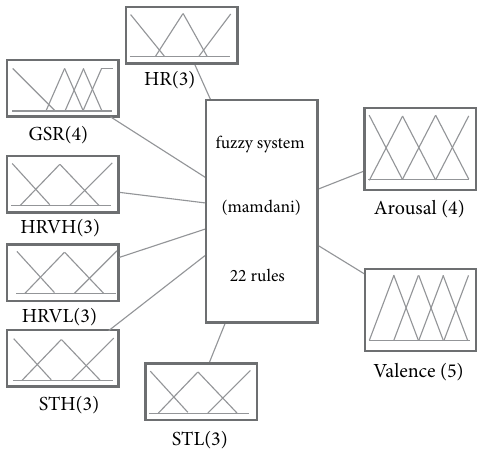
Fig. 5. The principal scheme of integrating different components of modelling emotions for defining fuzzy values of arousal and valence